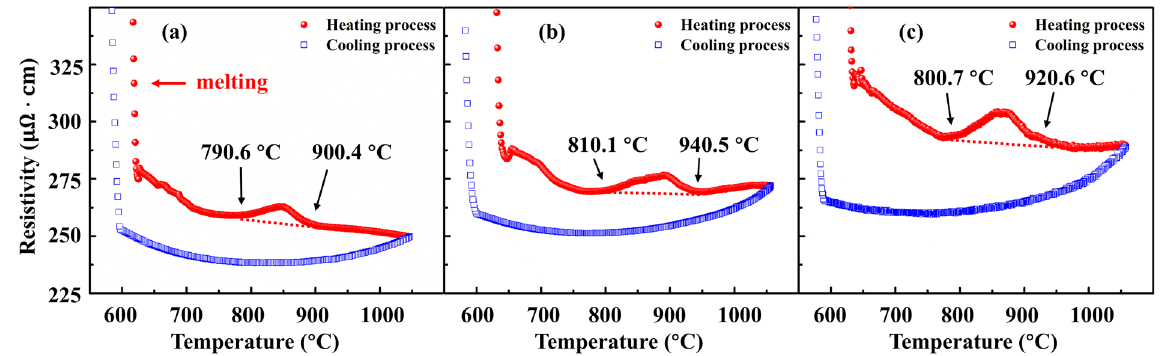
Figure 2. The ρ - T curves of liquid Bi 2 Te 3 − x Se x alloys during heating and cooling processes (5 °C/min). ( a ) x = 0.3; ( b ) x = 0.45; ( c ) x =